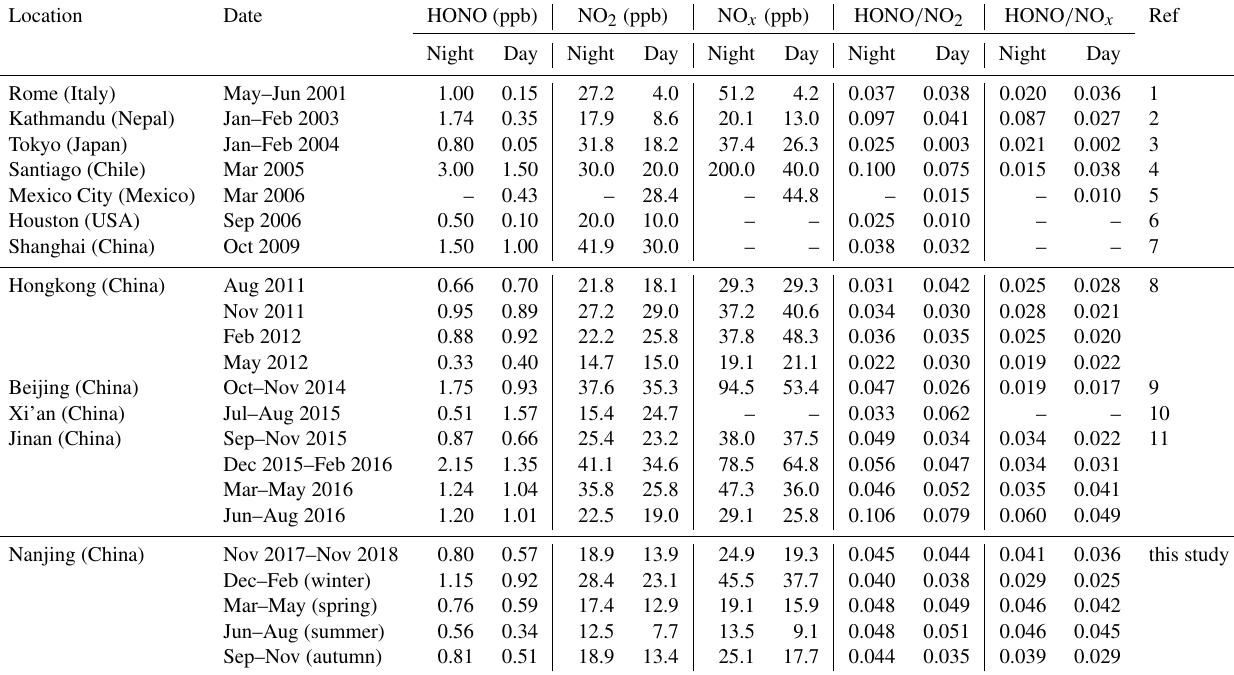
Table 2. Overview of the measured HONO and NO x levels in Nanjing and comparison with other urban or suburban sites. Location